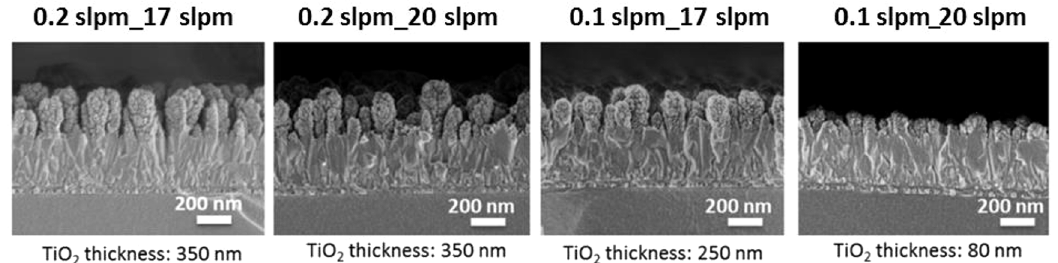
Fig. 4. FESEM images of fi lms elaborated with the different gas fl ow rates combinations ([TTIP fl ow rate]_[Ar plasma fl ow rate]) on glass/FTO substrates, from the plasma phase with the higher TTIP proportion (left) to the lower proportion.